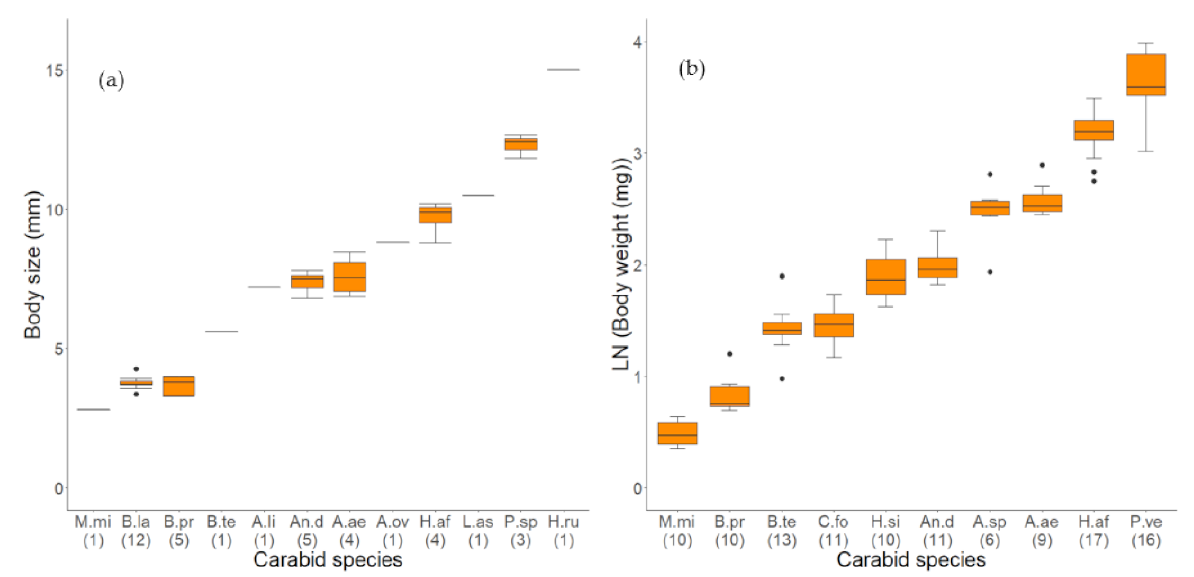
Figure 1. ( a ) Body size in mm, measured from the wingtips to the front of the forehead, of carabid species used to determine fungal loads by a culture-dependent method. ( b ) Body weight in mg (transformed LN(x + 1)) of carabid species, used to determine fungal loading a qPCR approach. Number of individuals per carabid species presented in brackets. Species code according to Table 1 ( a ) and Table 2 ( b ) (abbreviation